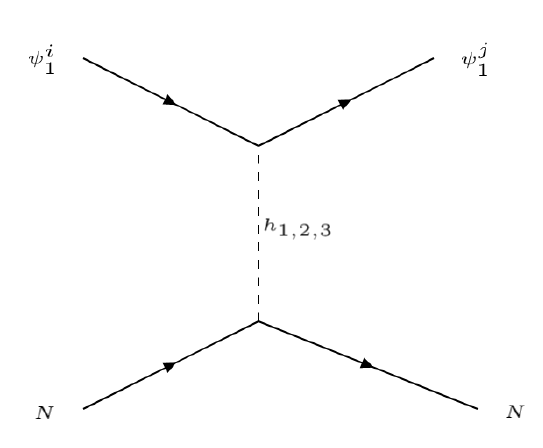
Figure 6 . Feynman graph showing the elastic spin independent direct detection scattering for DM 1 and nucleus via scalars h 1 ; 2 ; 3 . Note that, in this case i = j , while Z : f Z; Z B (cid:0) 3 L (cid:28) g mediated diagrams are forbidden due to inelastic stattering as i 6 = j .